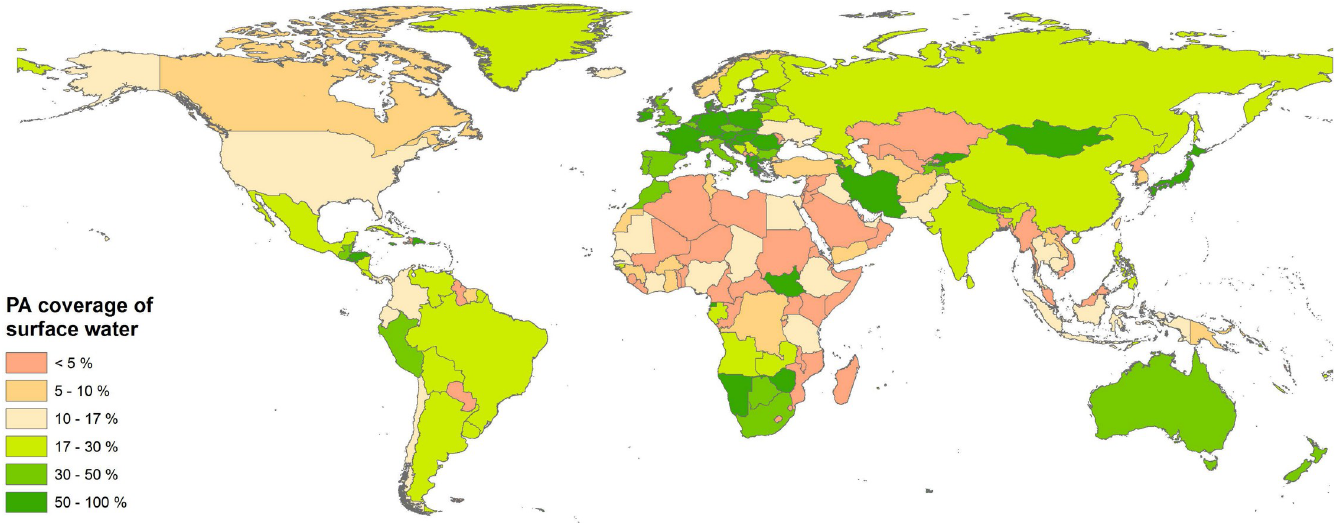
Fig 1. Coverage of surface waters (both seasonal and permanent) by protected areas in all countries.